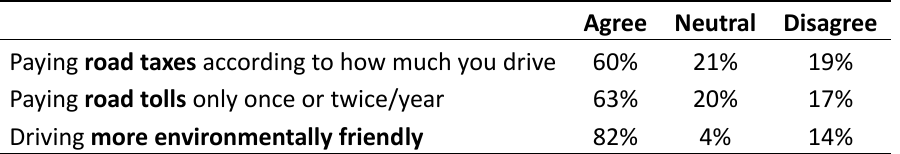
Table 4. Users’ opinions about the road tolling, road taxes and road-related location information in the context of